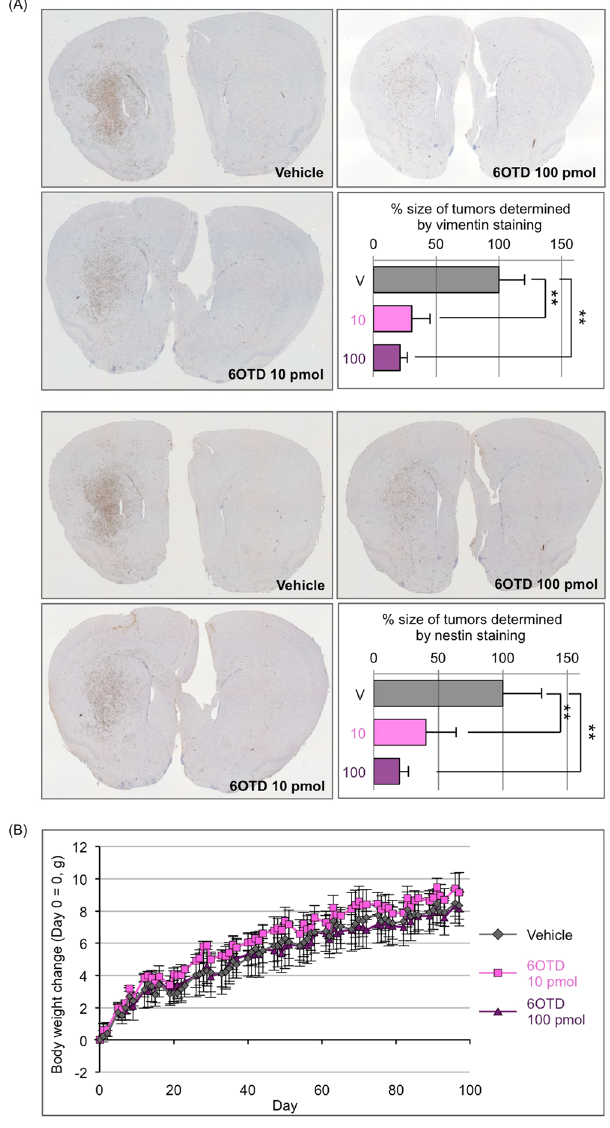
Figure 6. 6OTD suppresses GSC growth in vivo . ( A ) Effect of 6OTD on intracranial growth of GSCs in a mouse xenograft model. Each mouse was injected with 1.0% DMSO (vehicle) or 6OTD (10 or 100 pmol) intracranially on the same day as the GSC transplantation. n = 5 (vehicle) or 6 (6OTD-treated). Immunohistochemistry of mouse brains stained with human-specific anti-vimentin (top) or anti-nestin (bottom) antibodies. Original magnification of the images was 4 × . Graphs indicate the relative tumor size as determined by immunohistochemistry with the glioma markers described above. Error bars indicate the SD values ( ** P < 0.01). ( B ) Body weight change of vehicle and 6OTD- (10 or 100 pmol) treated